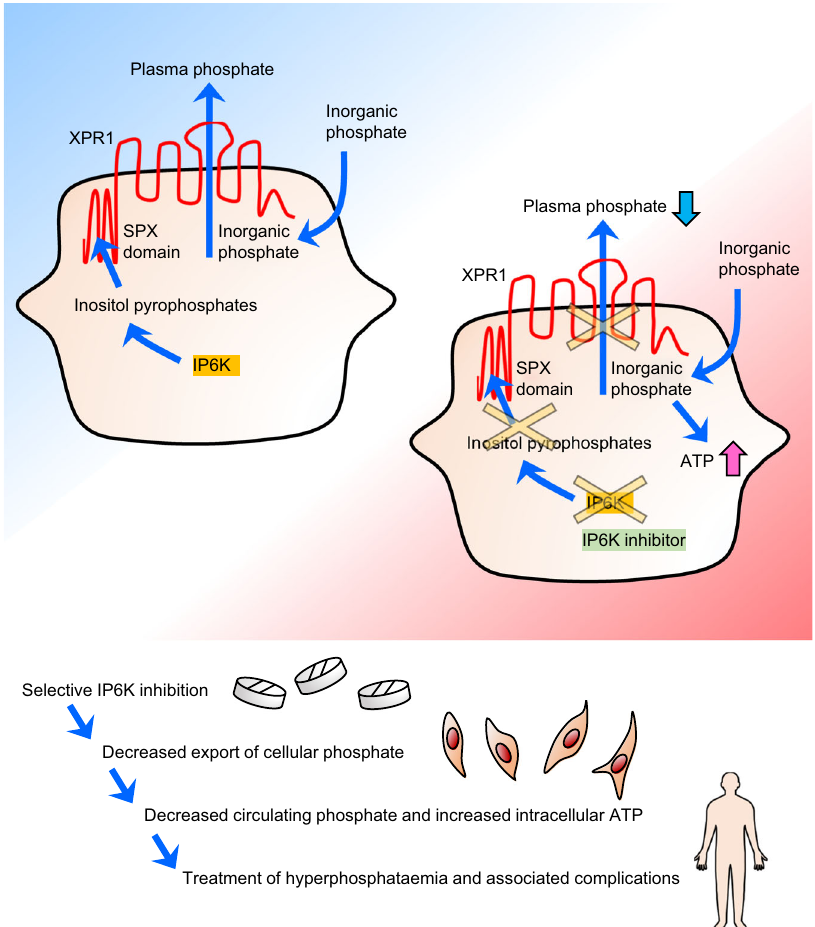
Fig. 7 Schematic representation of IP6K-mediated phosphate regulation and its therapeutic relevance. In the normal condition, IP6K stimulates cellular phosphate export via SPX domain of XPR1 , maintaining plasma phosphate levels in vivo. IP6K-inhibition-mediated reduction of InsP 7 inhibits phosphate export ability of XPR1 in cells, resulting in decrease in plasma phosphate levels in vivo. IP6K inhibition is therapeutically relevant and improves hyperphosphataemia and associated complications. IP6K inositol hexakisphosphate